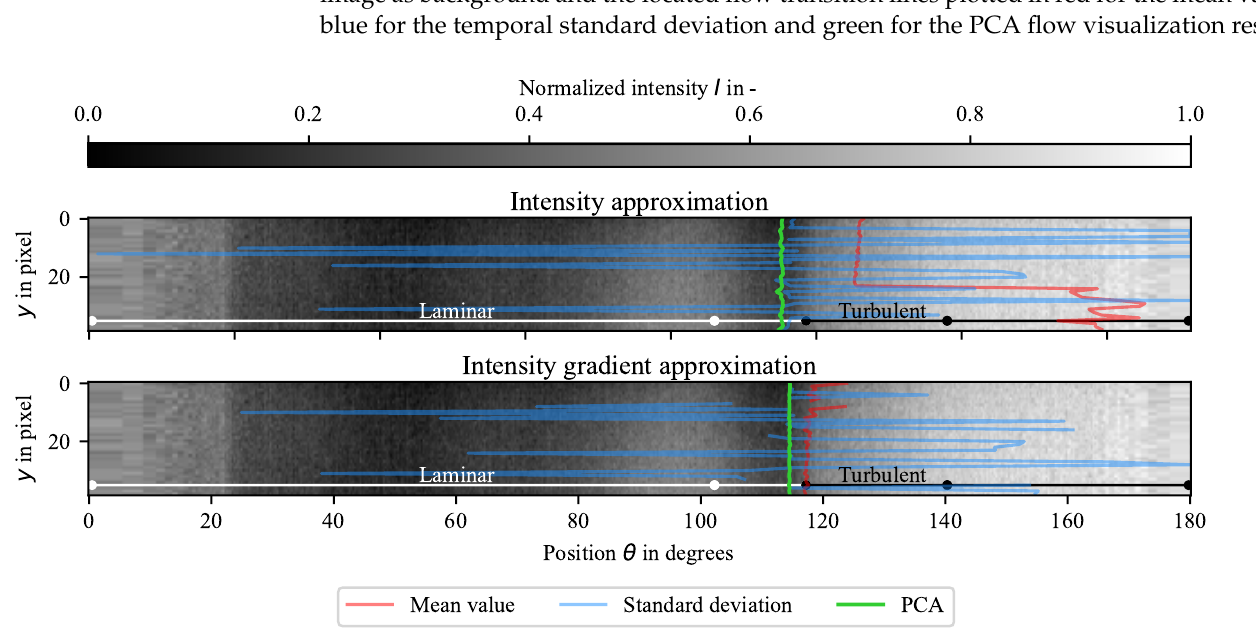
Figure 7. Comparison of the located laminar turbulent flow transition line by means of the temporal mean value (red), temporal standard deviation (blue) and PCA (green) flow visualization of the image series. Flow transition localization based on the approximation of the intensity profile (top) and approximation of the intensity gradient profile (bottom). For both methods, the localization in the PCA result has qualitatively the lowest random and systematic error.